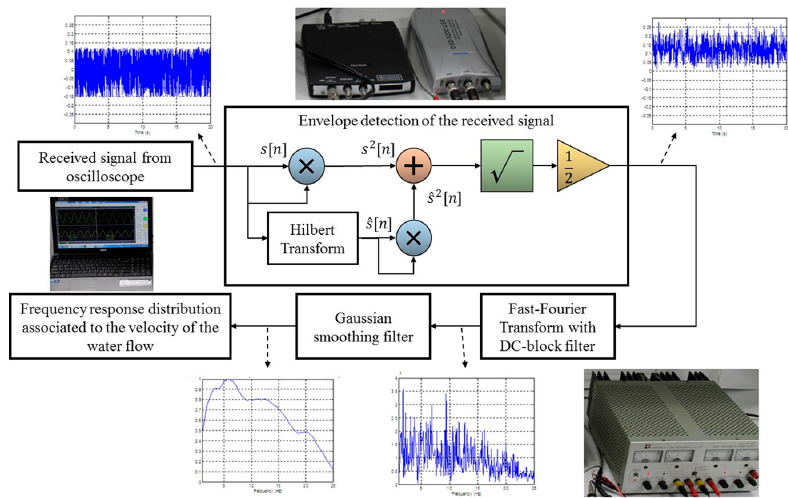
Figure 1. Flowchart of signal processing for water flow velocity/turbidity measurement.